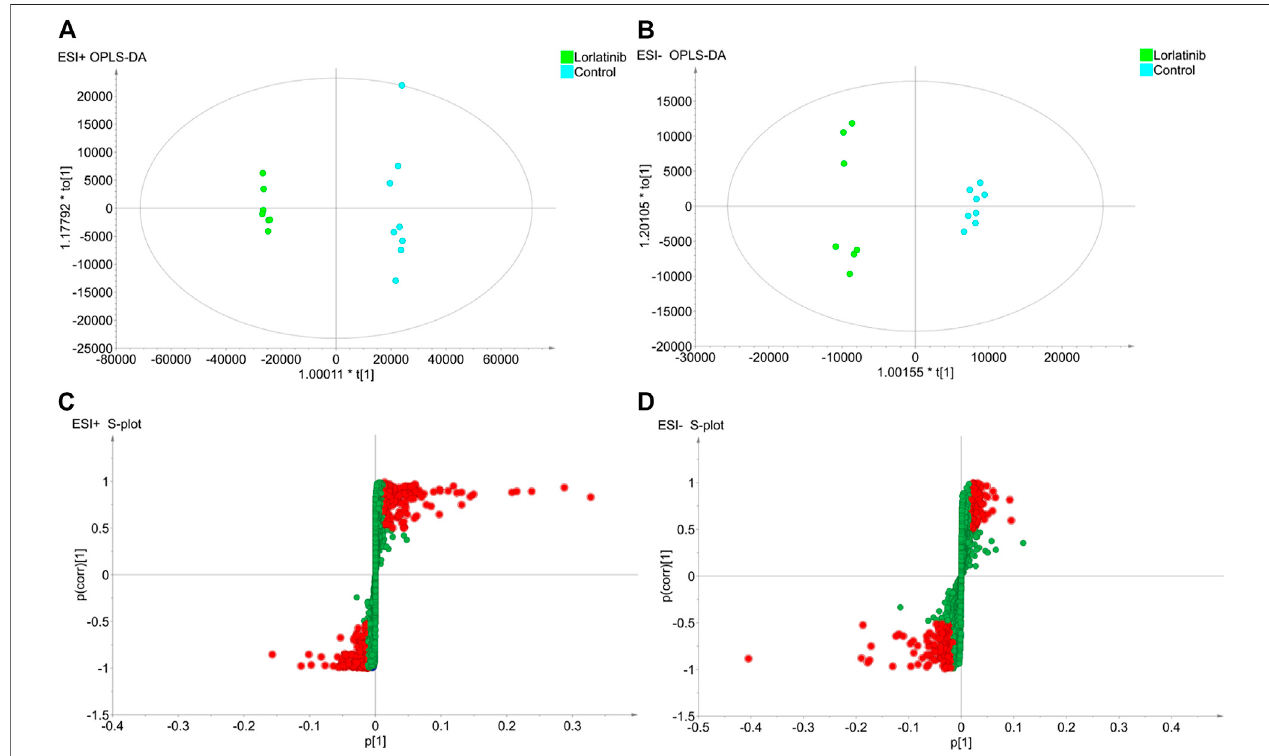
FIGURE 2 | The results of OPLS-DA modelling using the data from the lorlatinib and non-lorlatinib groups in positive (A) and negative (B) electrospray ionization source (ESI) mode and the S-score plots constructed from the results in positive (C) and negative (D) mode.